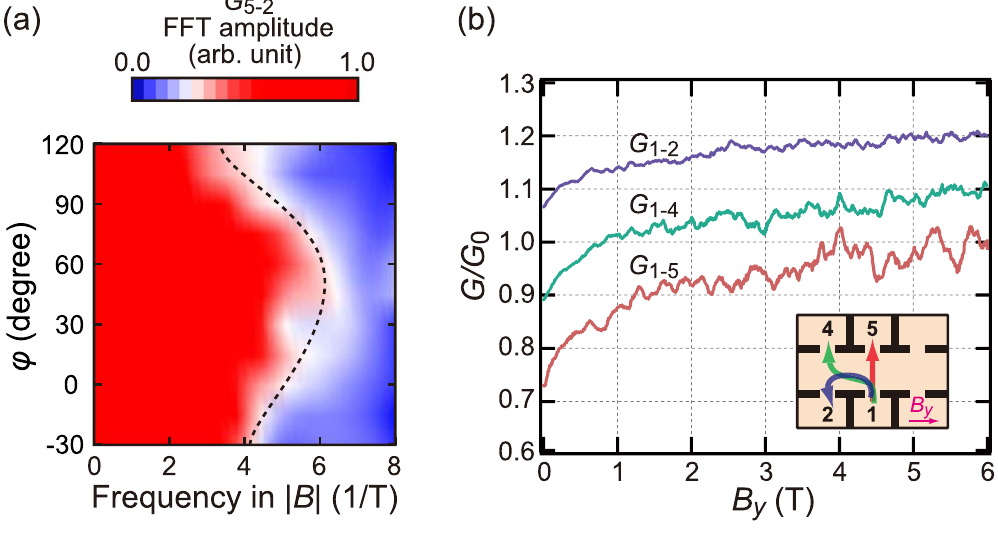
Figure 5. Effect of probe configuration. ( a ) The same FFT map as Fig. 4(b) but for G 5–2 at T = 150 mK. ( b ) G 1–2 , G 1–4 , and G 1–5 versus B y , for the configurations illustrated in the inset. The data are normalized by G 0 = G ( B y = 6T) and displayed with offset 0.1 G q